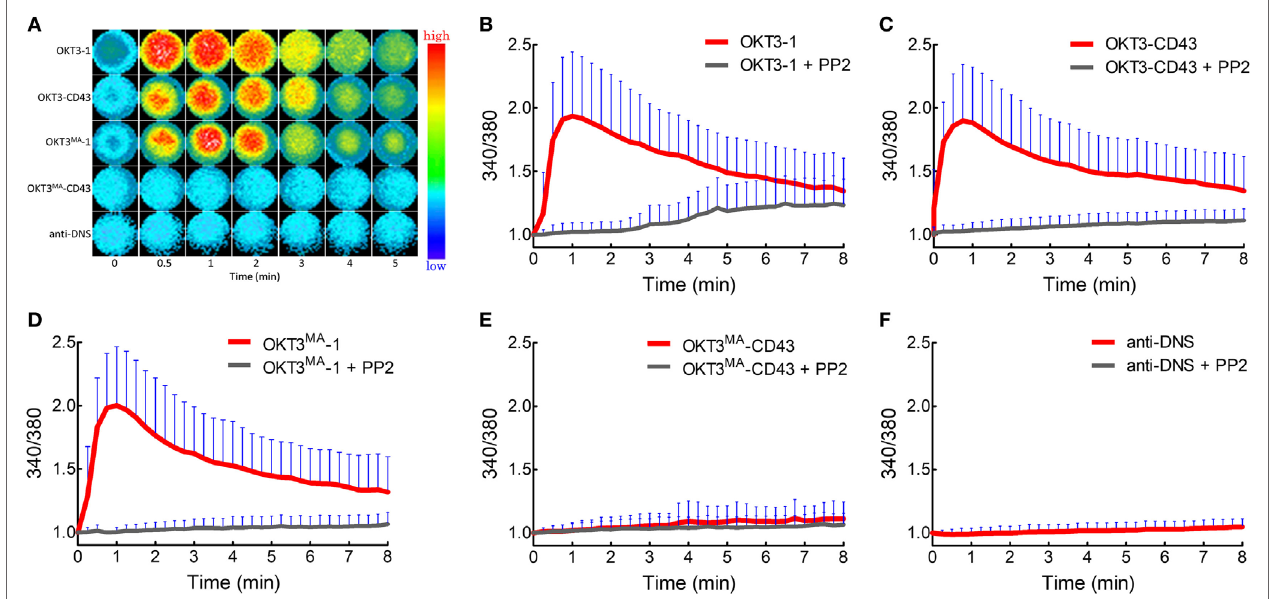
FigUre 3 | Calcium flux in Jurkat T cells stimulated with membrane-tethered anti-CD3 scFv. Jurkat T cells were dropped on planar lipid bilayers decorated with anti-CD3 scFv in the presence or absence of Lck inhibitor (PP2). The emission was measured from Fura-2AM labeled Jurkat T cells as the ratio between 340 and 380 nm at different times (min). (a) Ca 2 + flux measured from individual Fura-2AM stained Jurkat T cells. A heat map for Ca 2 + from individual Jurkat T cells over time. Mean ratiometric fluorescence of Fura-2AM loaded Jurkat T cells triggered by membrane-tethered OKT3-1 (B) , OKT3-CD43 (c) , OKT3 MA -1 (D) , OKT3 MA -CD43 (e) , or anti-DNS control scFv (F) ( n = 52 and 30 cells without PP2 and with PP2 inhibition, respectively). Bars,